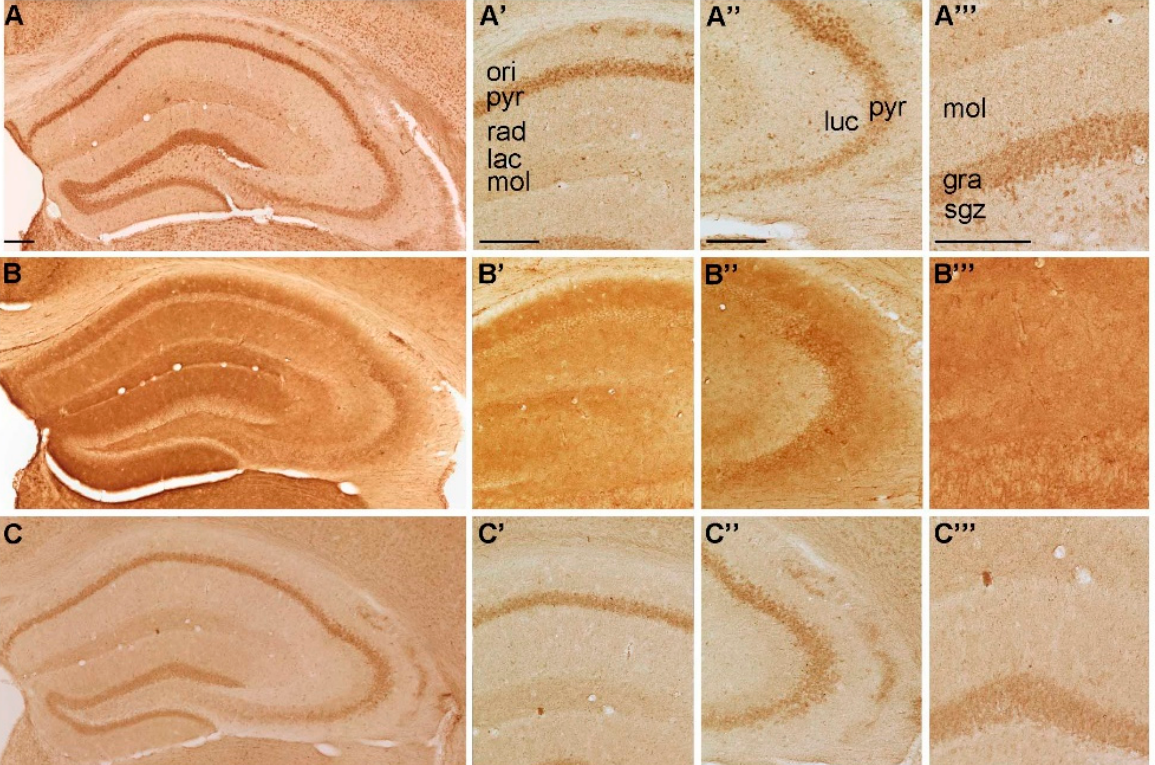
Figure 2. Representative microphotographs of ( A ) P2X5-, ( B ) P2X6-, and ( C ) P2X7-IR in the mouse hippocampus. At higher magnification ( A’ ) P2X5-IR in cornu ammonis (CA) 1, (A’’) P2X5-IR in cornu ammonis (CA) 3, ( A’’’ ) P2X5-IR in dentate gyrus, ( B’ ) P2X6-IR in cornu ammonis (CA) 1, ( B’’ ) P2X6-IR in cornu ammonis (CA) 3, ( B’’’ ) P2X6-IR in dentate gyrus, ( C’ ) P2X7-IR in cornu ammonis (CA) 1, ( C’’ ) P2X7-IR in cornu ammonis (CA) 3 and (C’’’) P2X7-IR in dentate gyrus, respectively. Abbreviations: ori, stratum oriens, pyr, stratum pyramidale, rad, stratum radiatum; lac, stratum lacunosum; mol, stratum moleculare; luc, stratum lucidum; gra, stratum granulare, sgz, subgranular zone. Scale bars = 200 µm.